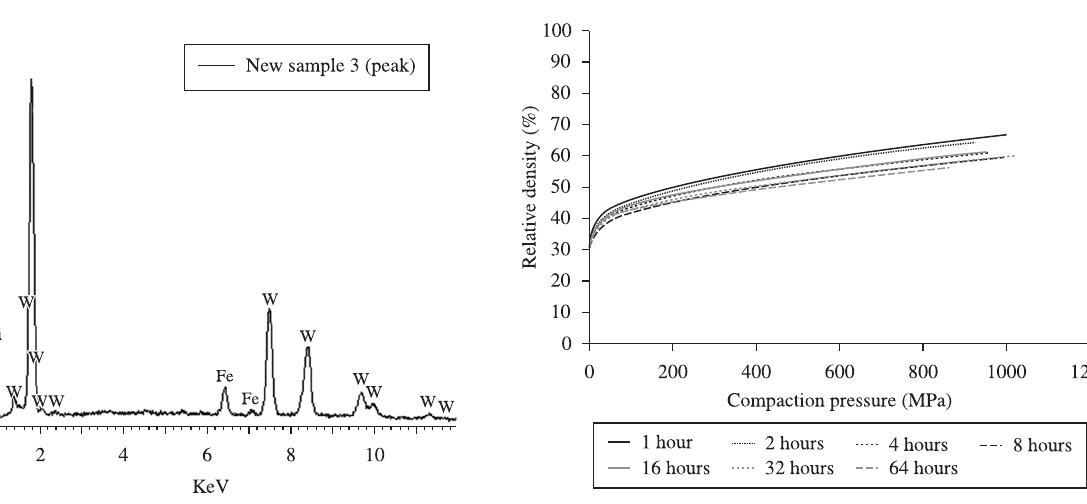
Figure 10. Compressibility curves of the ball milled WC-20Ni